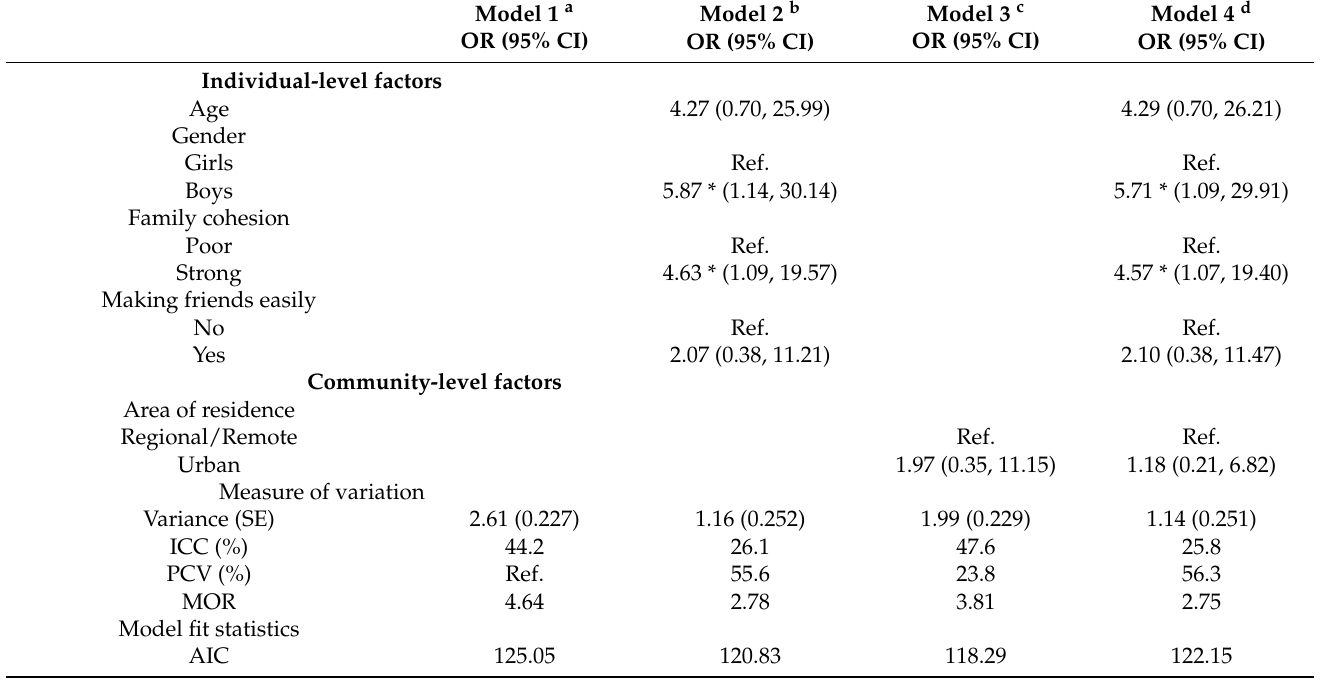
Table 6. Protective factors against